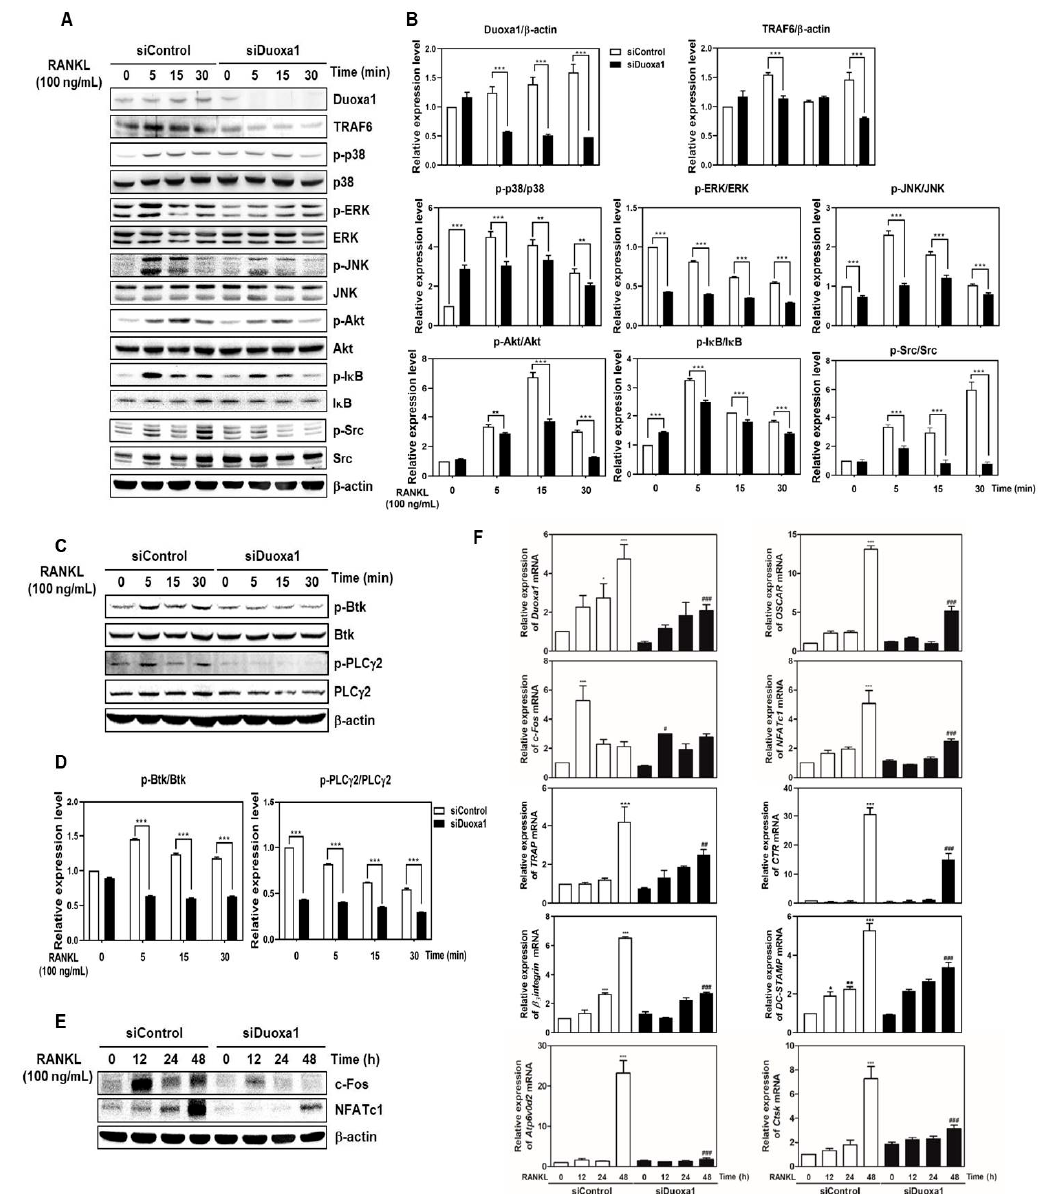
Figure 2. Knockdown of Duoxa1 suppresses c-Fos and NFATc1 expression accompanied by regulating the TRAF6-mediated signal pathway. ( A – E ) BMMs transfected with siControl or siDuoxa1 were stimulated with RANKL (100 ng / mL) for the indicated time points. Whole cell extracts were probed with the indicated antibodies. β -actin was used as an internal control. The graph indicates the phosphoprotein-to-total protein rations of each molecule or the TRAF6 to β -actin. Quantification of relative ratio of band intensity was performed using Image J software. The phosphoprotein-to-total protein or the TRAF6 ratios (relative expression levels) are represented as the mean ± standard deviation. ** p < 0.01, *** p < 0.001 versus siControl at each time. ( F ) BMMs transfected with siControl or siDuoxa1 were stimulated with RANKL (100 ng / mL) for the indicated time periods. The mRNA expression of the indicated genes was analyzed by qRT-PCR. Data are presented as the mean ± SD of three independent experiments. * p < 0.05; *** p < 0.001 versus the siControl at 0 h; # p < 0.05, ## p < 0.01, ### p < 0.001 versus siControl at each time.